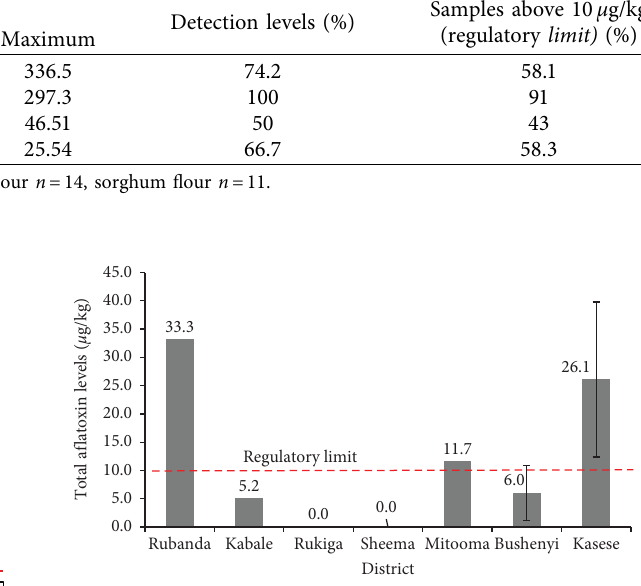
Figure 3: Total afatoxin levels in millet four samples in selected districts of S.W. Uganda. (Te regulatory limit for E Africa is in broken lines).